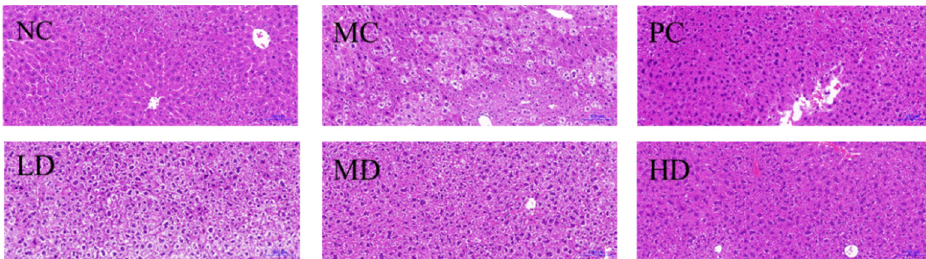
Figure 5. Hepatic lipid accumulation in mice fed experimental diets for 30 days. H&E staining of liver specimens. NC: normal group (normal feed, 0.9% saline); MC: model group (HFD, 0.9% saline); PC: positive group (HFD, 0.5 mg/mL xuezhikang capsules); LD: RFV low dose group (HFD, 10% RFV); MD: RFV medium dose group (HFD, 30% of RFV); HD: RFV high dose group (HFD, 50% of RFV).